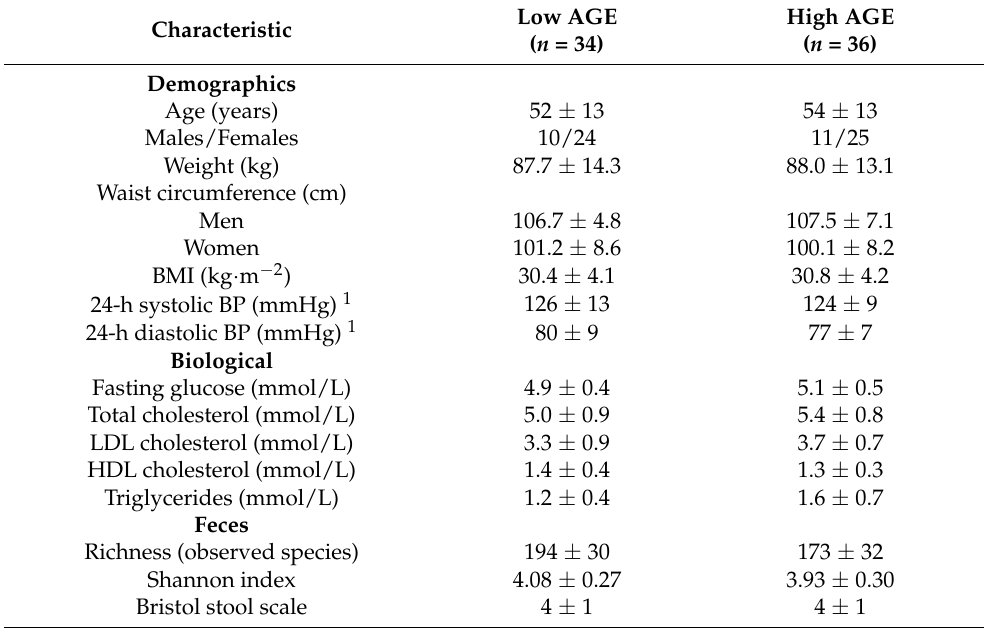
Table 1. Characteristics of 70 abdominally obese individuals included in the deAGEing trial at baseline.